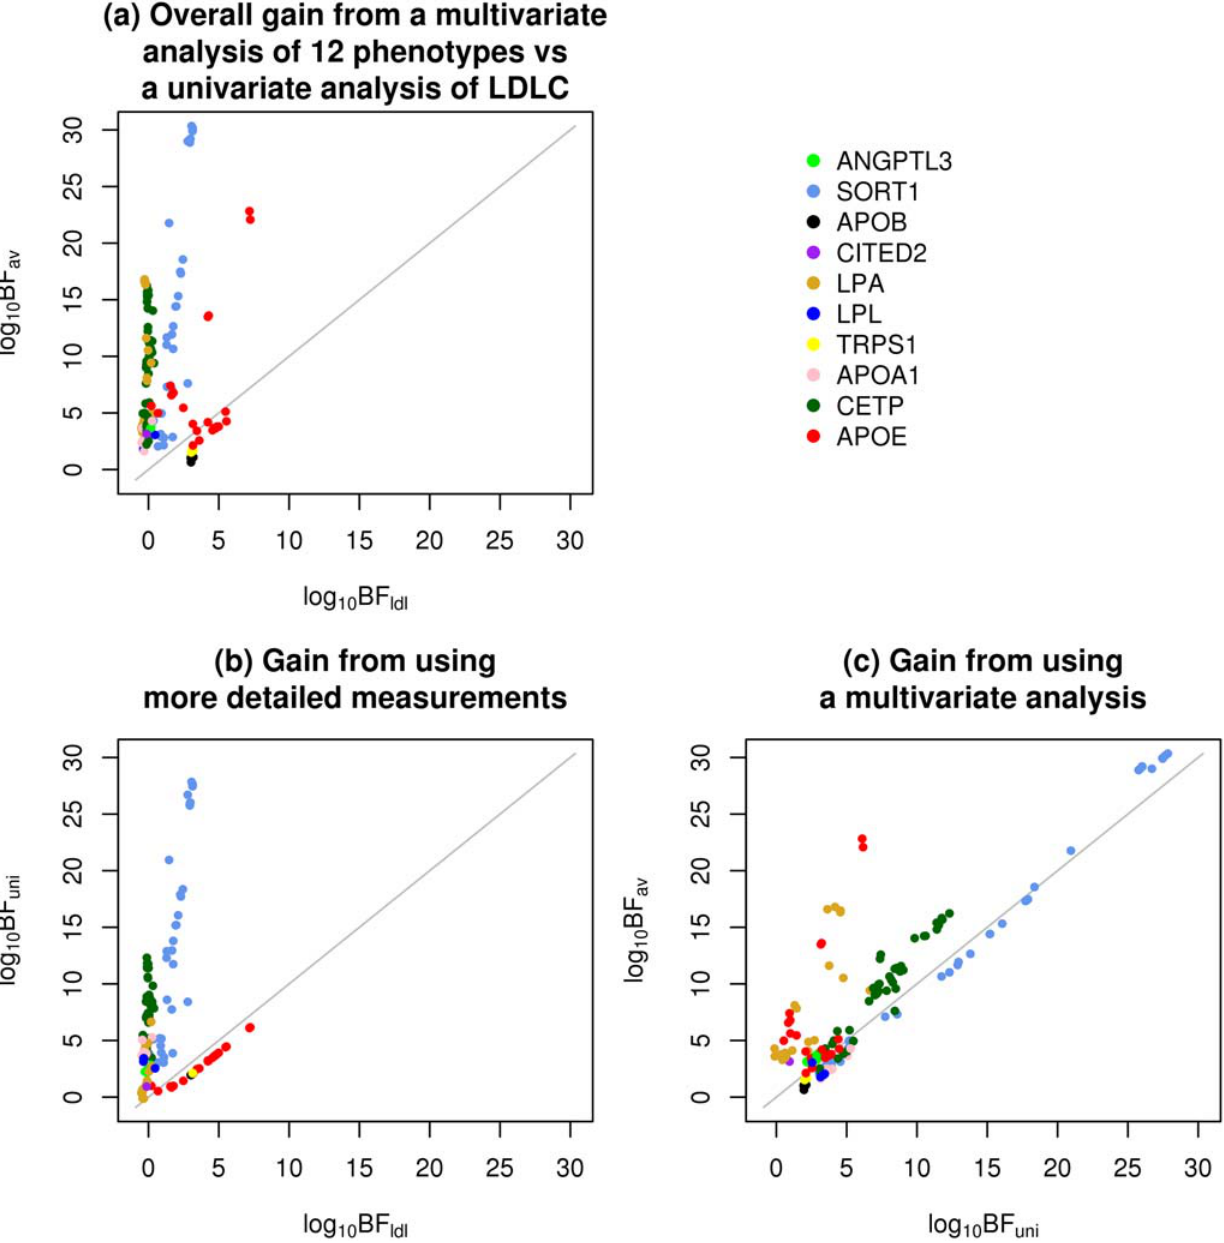
Fig 5. Decomposition of the gain (or loss) from a multivariate analysis of 12 phenotypes vs a univariate analysis of LDL-C into two components: one from using more detailed measurements, and one from using a multivariate analysis. Plotted are (a) log 10 BF av (the BF based on multivariate analysis of all 12 phenotypes) vs log 10 BF ldl (the BF based on univariate analysis of LDL-C), (b) log 10 BF uni (the BF based on univariate analysis of all 12 phenotypes) vs log 10 BF ldl , and (c) log 10 BF av vs log 10 BF uni . SNPs are colored according to the nearest